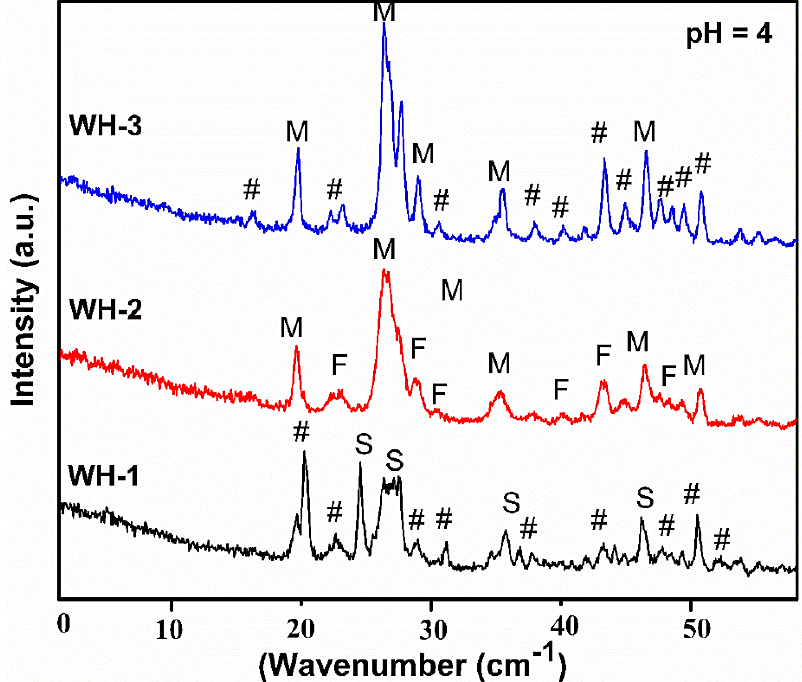
Figure 2. Powder X-ray diffraction (PXRD) diffractograms of the first batch of products (WH-1, WH-2, WH-3) (S for Stanfieldite, F for Farringtonite, M for Monetite and # for mixed CaP phases). XRD analysis of the second batch of products (WH-4, WH-5 and WH-6) is shown in Figure 3.